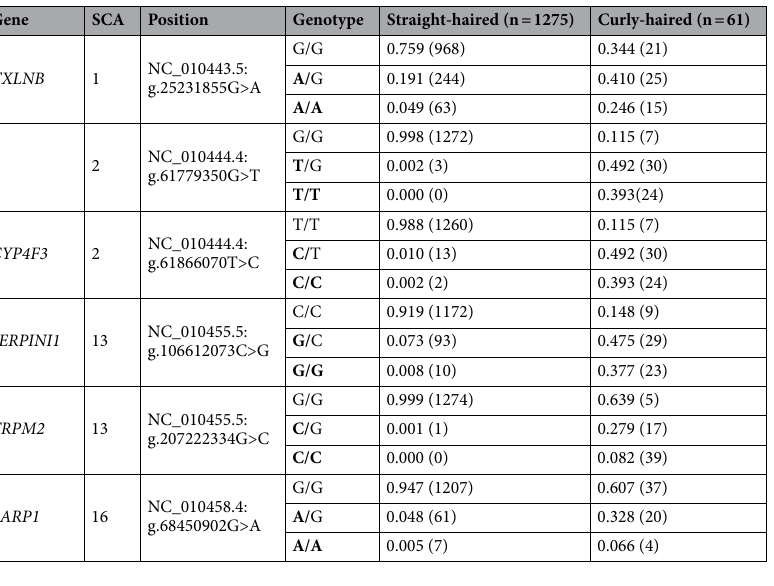
Table 1. Genotype frequencies of five candidate SNPs for curly validated in imputed data. Curly-associated alleles are printed in bold.